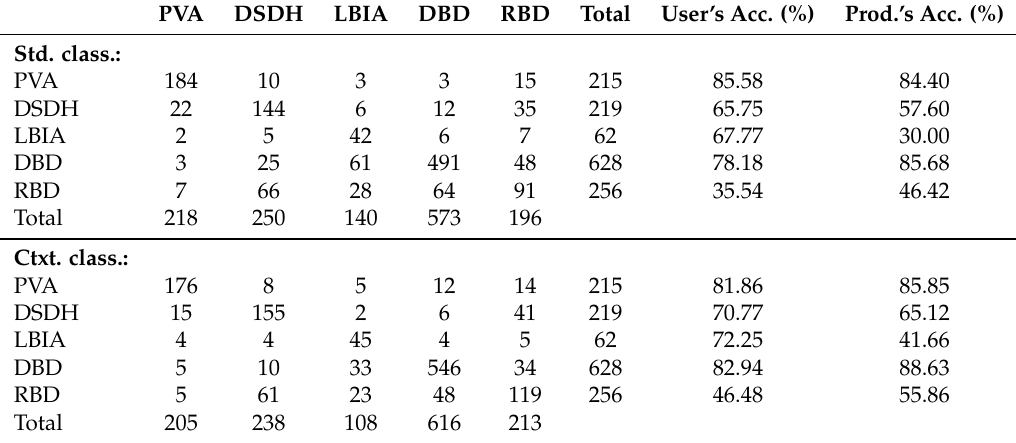
Table 5. The confusion matrices of the standard and best context-based classifications. The best contextual classification was obtained with model CRF 1 and the neighborhood definition criterion of a fixed radius of 240 m. The overall accuracies achieved by the standard and contextual classifications are 68.91% and 75.95%, respectively. The respective Kappa indices are 0.57 and 0.65. The considered classes are Parks and Vegetated Areas (PVA), Detached and Semi-Detached Housing (DSDH), Large Buildings and Industrial Areas (LBIA), Dense Block Development (DBD) and Regular Block Development (RBD). PVA DSDH LBIA DBD RBD Total User’s Acc. (%) Prod.’s Acc. (%) Std.